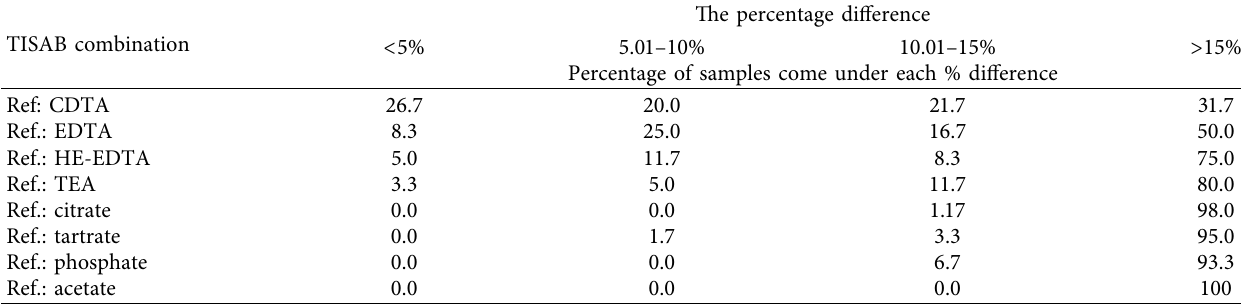
Table 2: The percentage difference of fluoride concentrations between the reference and selected TISAB solutions. TISAB combination